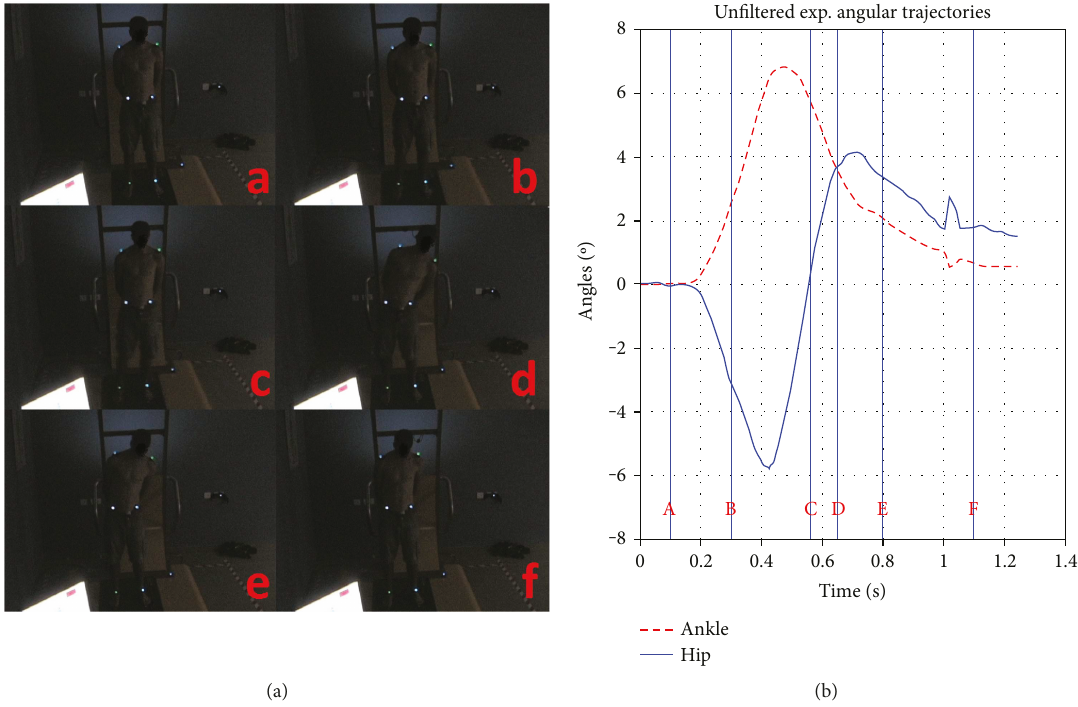
Figure 4: (a) Typical frames of the experiment, from a single trial, at the distinguished phases (A, B, C, D, E, F). (b) Corresponding trajectories of the hip and ankle angle, horizontal lines correspond to the phases. See also Appendix D for further reading.